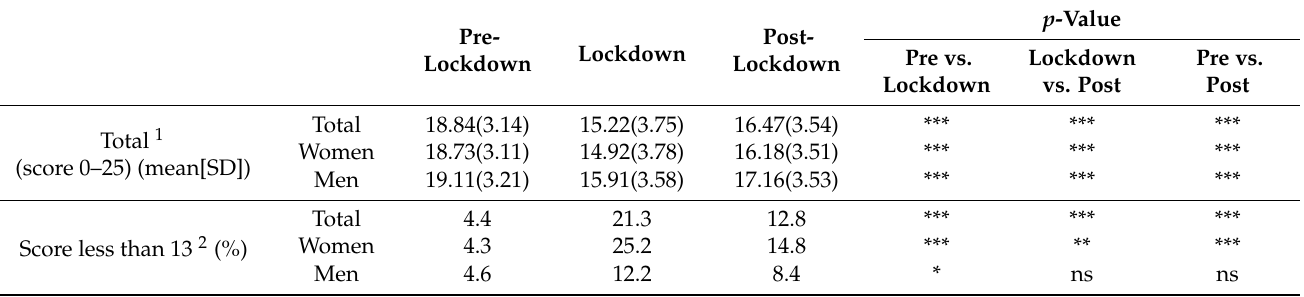
Table 1. WHO-5 well-being index.